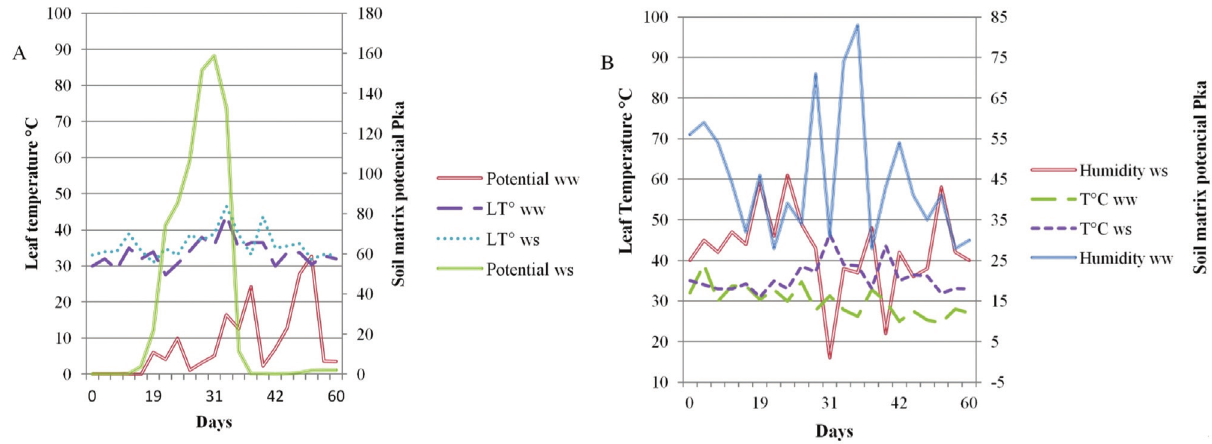
Figure 1 - Environmental parameters and soil matrix potential measured every two days during the first 60 days after planting. (A) Leaf temperature and soil water tension, (B) Greenhouse humidity and